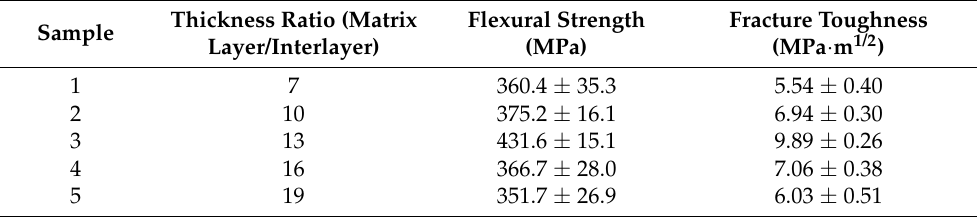
Table 1. Flexural strength and fracture toughness of the laminated ceramics with different layer thickness ratios.